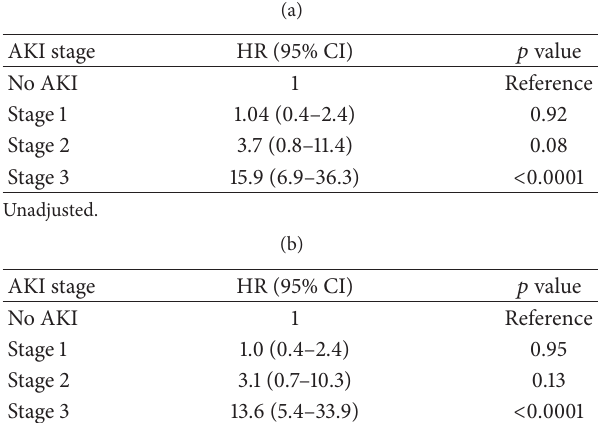
Table 5: (a) Unadjusted Cox proportional hazard ratio for one-year mortality by AKI stage. (b) Adjusted Cox proportional hazard ratio for one-year mortality by AKI